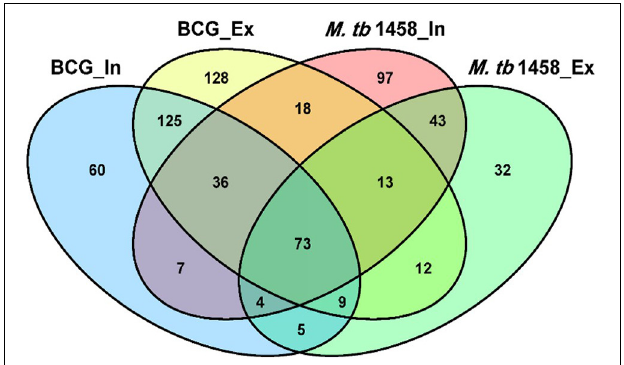
FIGURE 3 | Mycobacterium tuberculosis 1458/BCG count distribution of differentially expressed ncRNAs in different types between intracellular and extracellular bacteria (| FC| > 1.5).